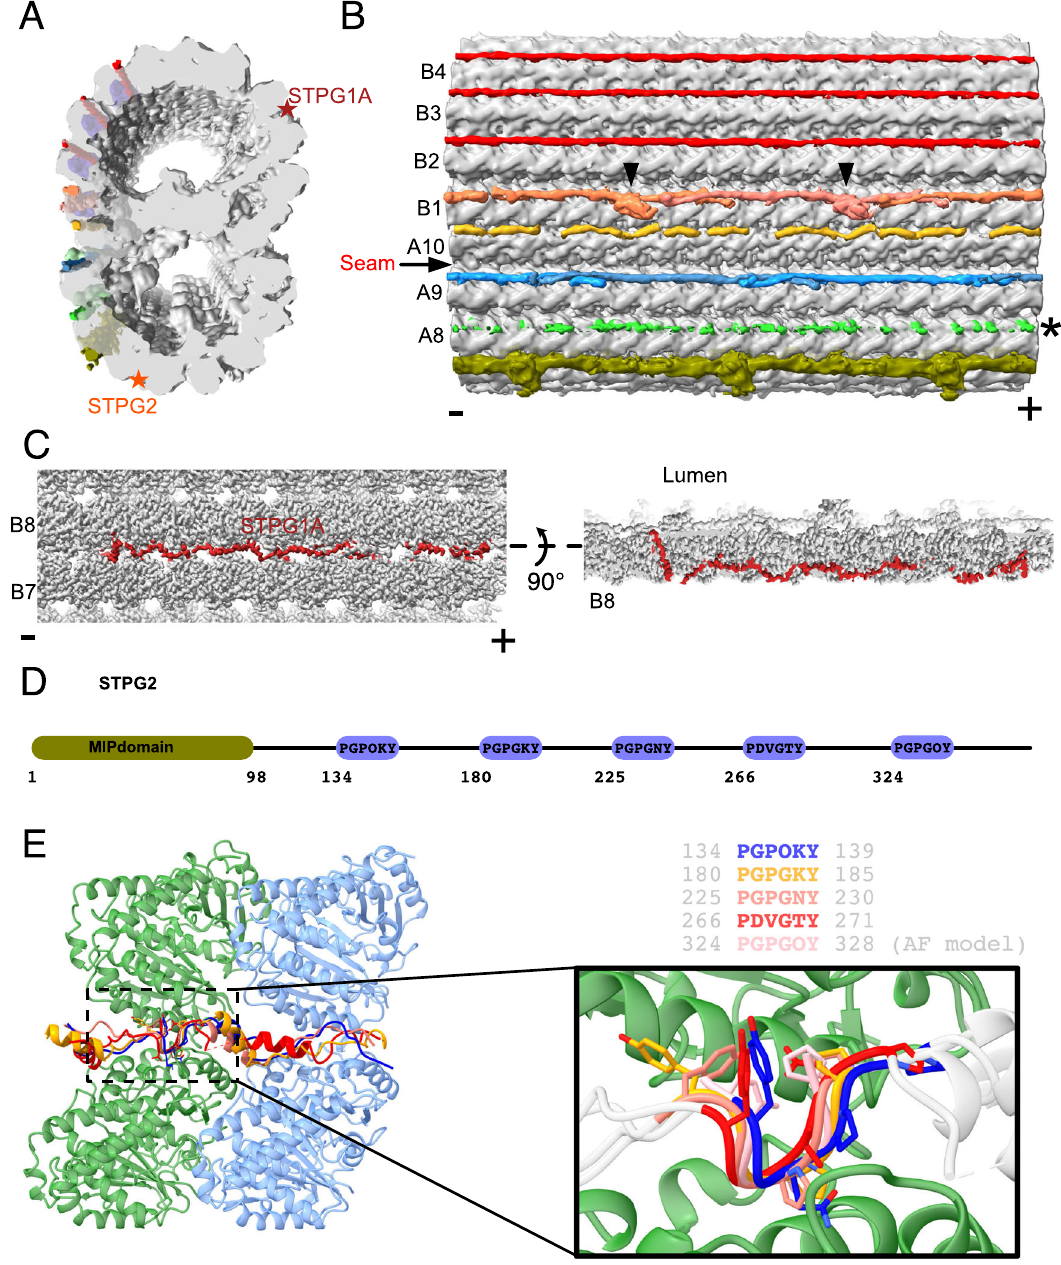
Fig. 4 | The outer surface fi laments on the native DMT. A , B Cross-sectional (A) andlongitudinal( B )viewsoftheoutersurface fi lamentsonthenative Tetrahymena DMT.The fi lamentsareboundtoadjacentpairsofPFsfromA8toB5.The fi laments between PFs B2-B3, B3-B4, and B4-B5 appear similar and have a 48-nm periodicity. In contrast, the fi laments between PFs A9-A10, A10-B1, and B1-B2 appear to have a 24-nm periodicity. These fi laments have a clear head-to-tail periodic arrangement between PFs A9-A10 and B1-B2. The fi lament between PFs B1B2 has a globular